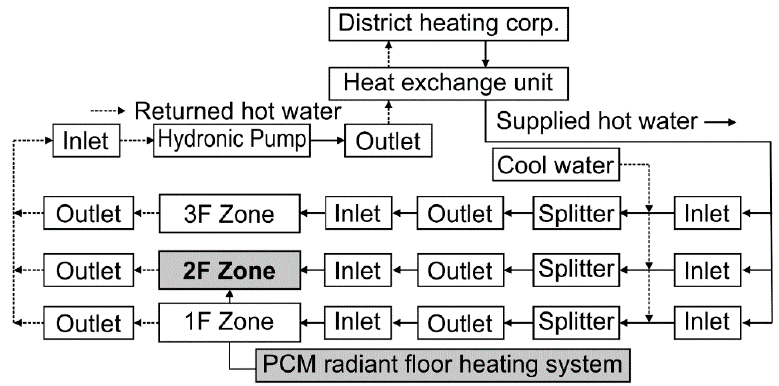
Figure 8. Connection loop of each unit for circulation of hot water in EnergyPlus.